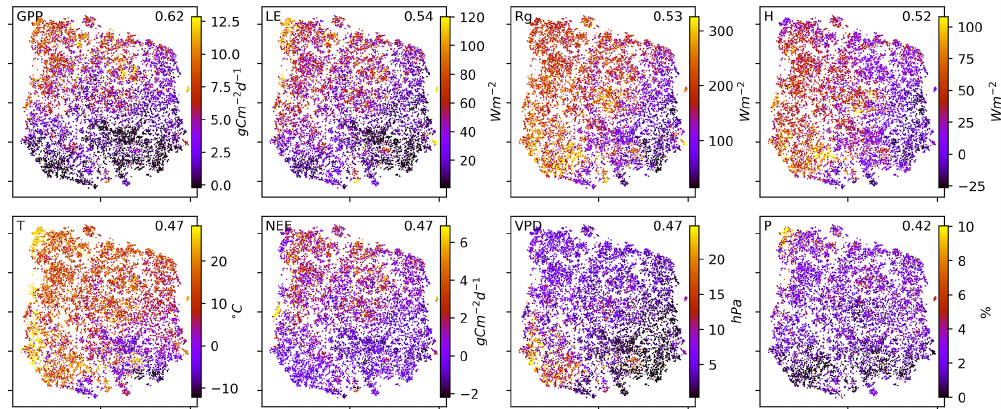
Figure 3. Two-dimensional embedding coloured by underlying mean exchange rates and meteorological conditions. The mean values are calculated over the respective time periods used for the network estimation. Each network is estimated on a 3-month window of daily time series data. Values are cut off at the highest and lowest percentile. Distance correlation of the shown quantity with the axes is given in the upper-right corner of each panel.